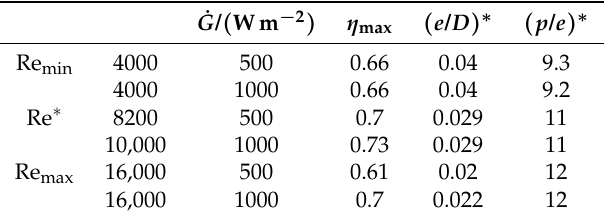
Table 12. Maximum efficiency and optimum roughness parameters according to the model developed by Alam and Kim [49].